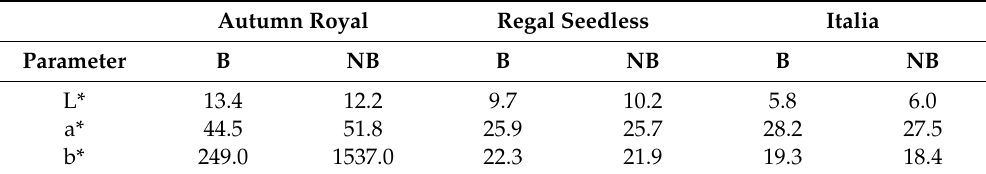
Table 4. Coe ffi cient of variation ( ± c.v. %) of skin CIEL*a*b* color parameters, L*(Lightness), a*(red / green coordinate), and b*(yellow / blue coordinate), of bagged (B) and not bagged (NB) berry skin of the three table grape varieties.